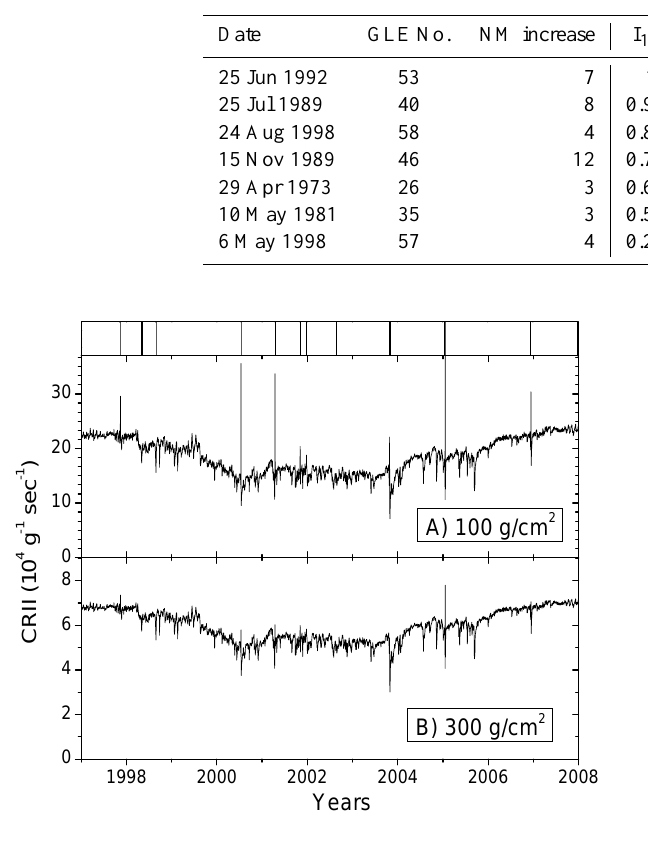
Fig. 6. Daily cosmic ray induced ionization at two atmospheric layers, 100 g/cm 2 (panel A) and 300 g/cm 2 (panel B), during the solar cycle # 23. Note that the CRII value for the day of 2005-Jan-20 goes far beyond the Y-scale of panel A. Dates of the GLE events #55 through 70 (see Table 1) are indicated inthetoppanel.